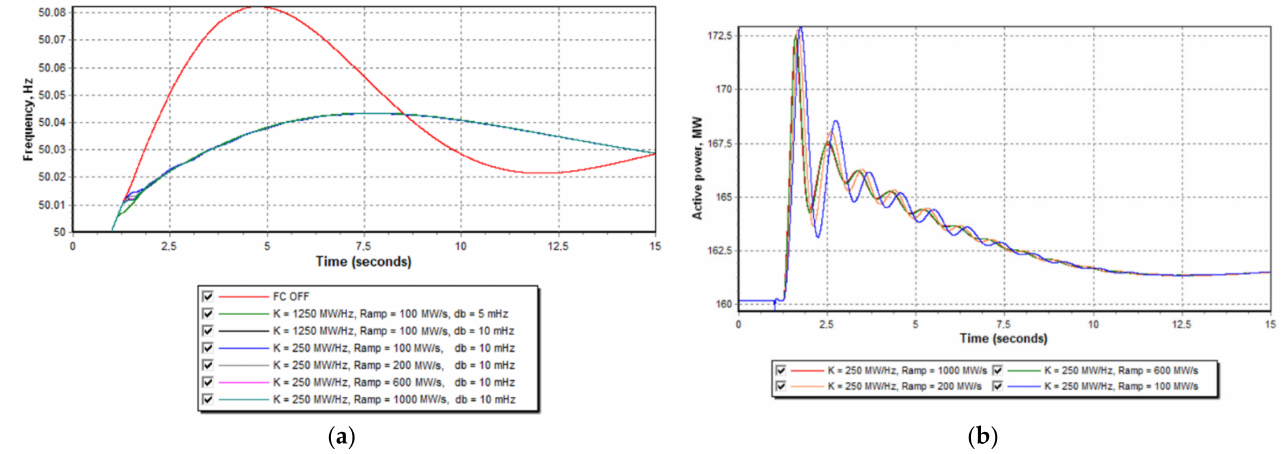
Figure 13. ( a ) Frequency change in the isolated power system—synchronous condenser disconnection.